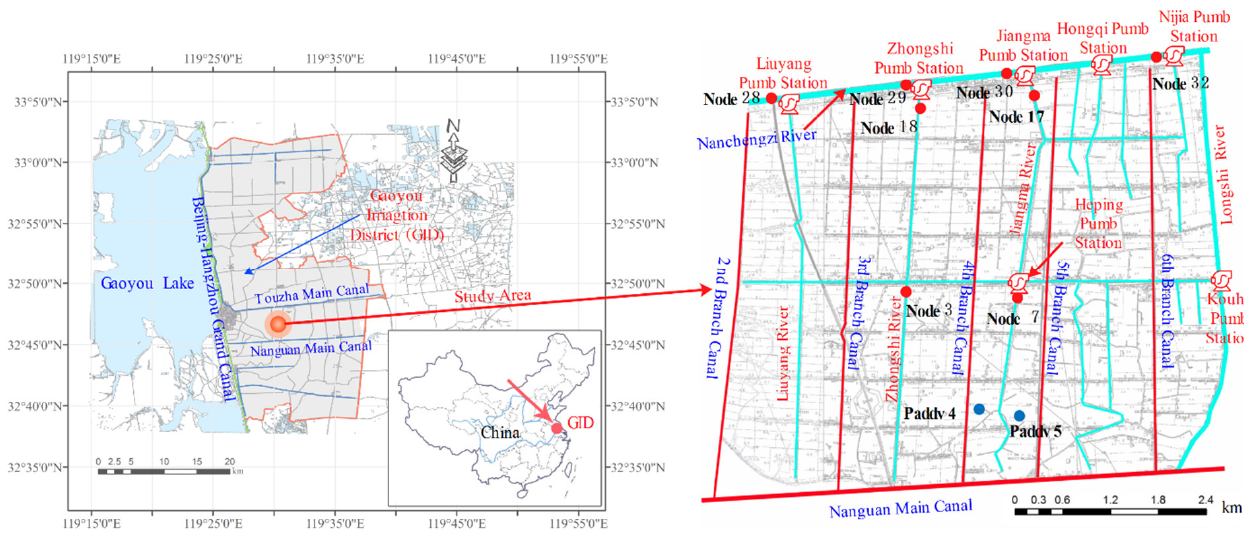
Figure 1. Basic overview of the test area.